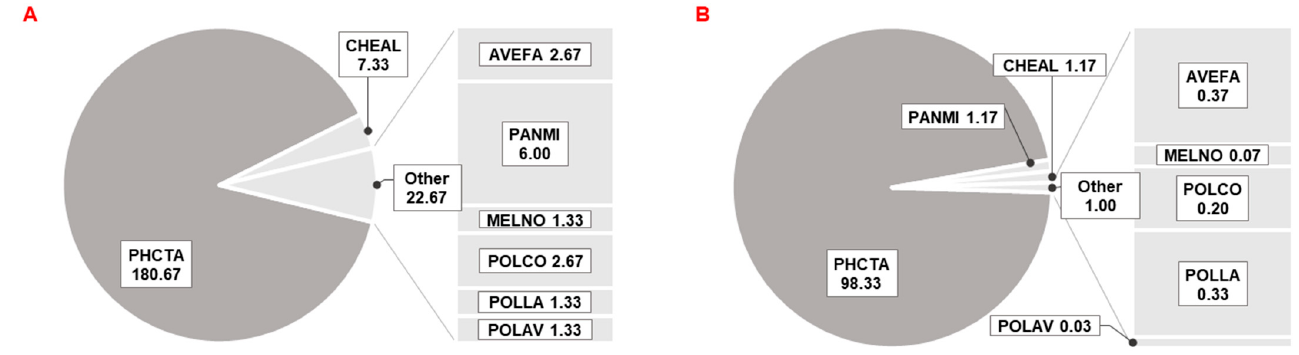
Figure A7. Number of plants per m 2 —Sowing 1 (8th of April) in 2020 ( A ) and leaf coverage in %— Sowing 1 (8th of April) in 2020 ( B ).